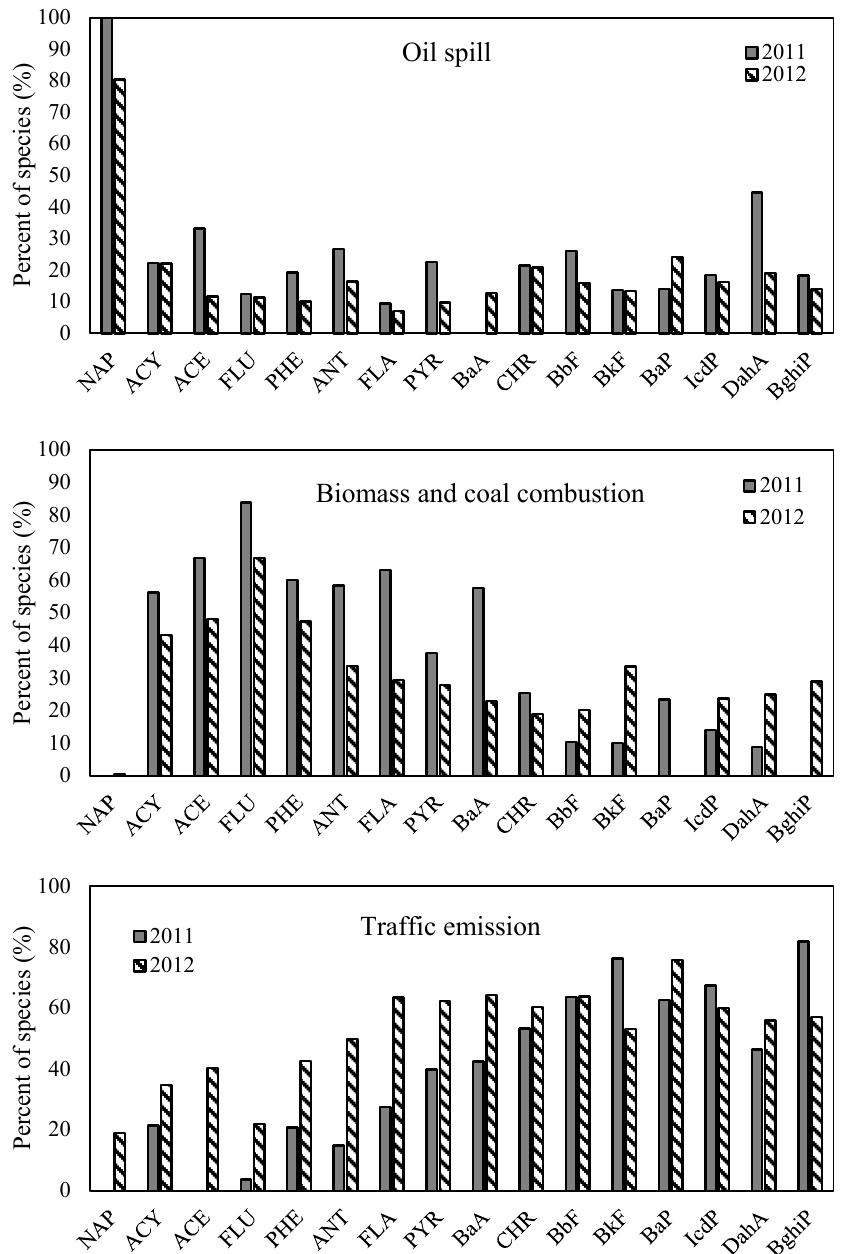
Figure 3. PAHs source profiles in 2011 and 2012 based on original PMF modeling result.